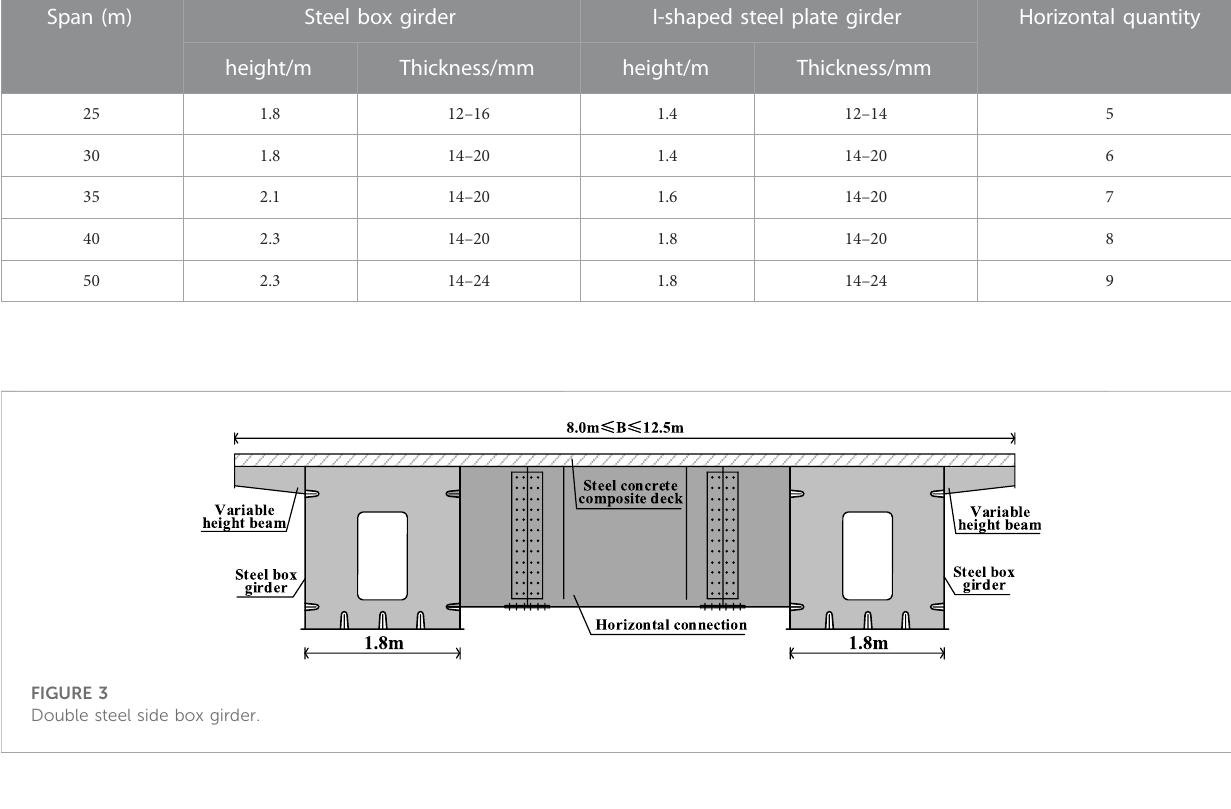
TABLE 1 Structural Parameters of Steel box-Steel plate Composite Beam. Span (m)